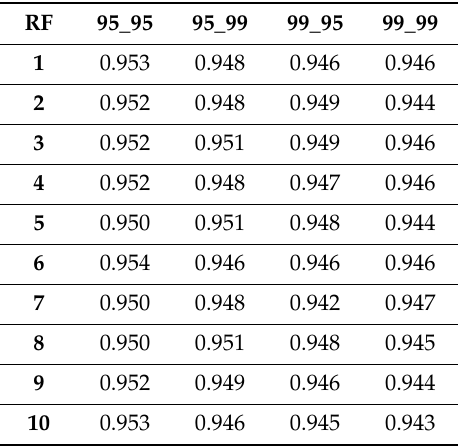
Table 9. F-measure value with di ff erent cleansing levels for RF against the corresponding cleaned test set.